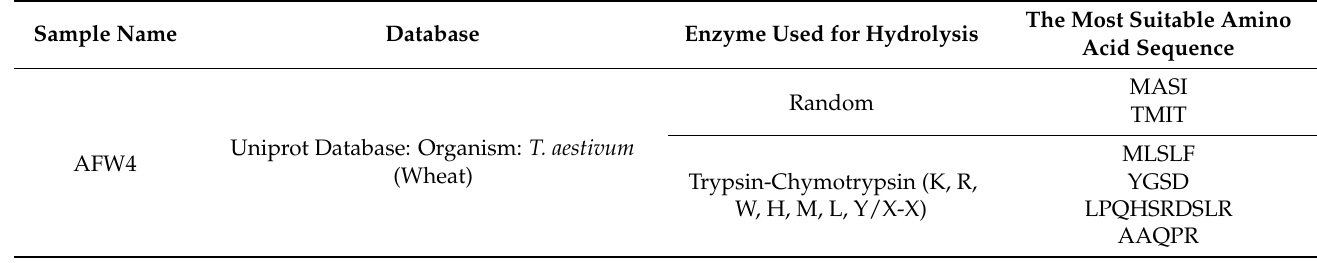
Table 1. The peptide sequences of AFW4 inferred from Uniprot ( Triticum aestivum